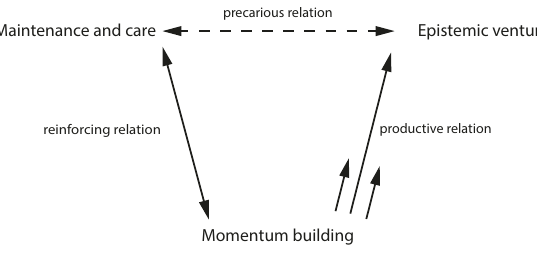
Fig. 1 Protected space enactment. Overview of the grantees ’ priority areas and the relationships between